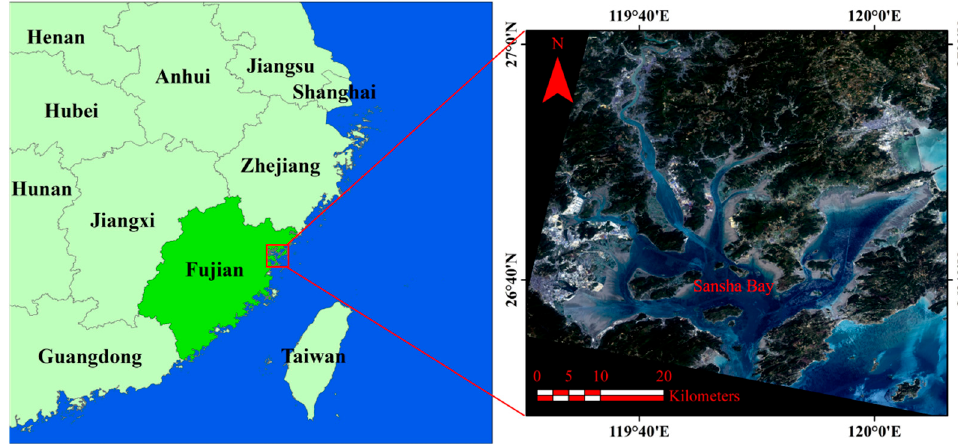
Figure 1. Location of the study area of Sansha Bay, Fujian Province.